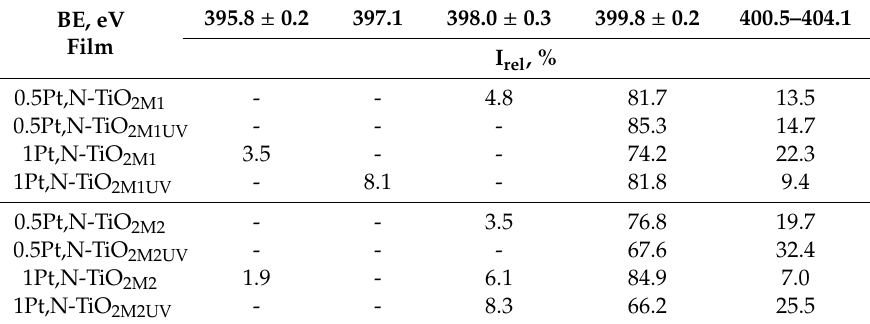
Table 3. Binding energy values of N1s peaks and their relative intensity (I rel ).